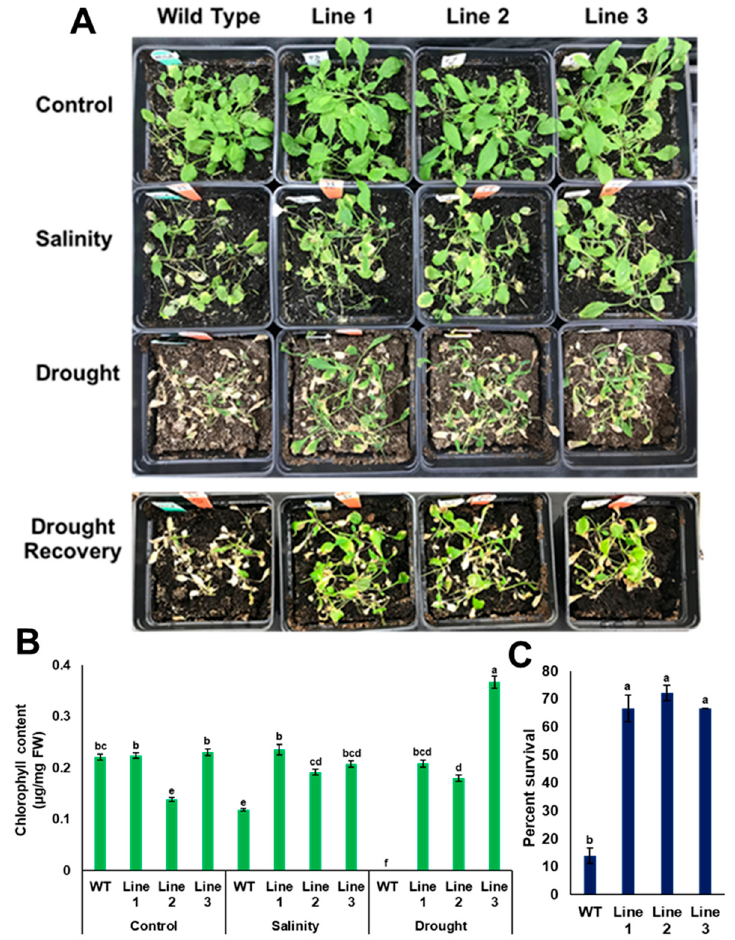
Figure 10. Heterologous overexpression of PdPIP1;2 enhanced tolerance to salinity and drought recovery in Arabidopsis. Tolerance ( A ) and total chlorophyll content ( B ) of WT and transgenic Arabidopsis lines in the case of salinity (200 mM NaCl), drought and drought recovery. Survival percentages of the plants rewatered and recovered from drought treatment ( C ). The bars represent the mean ( ± SE, n = 3), while the asterisks indicate a significant di ff erence to WT at p <